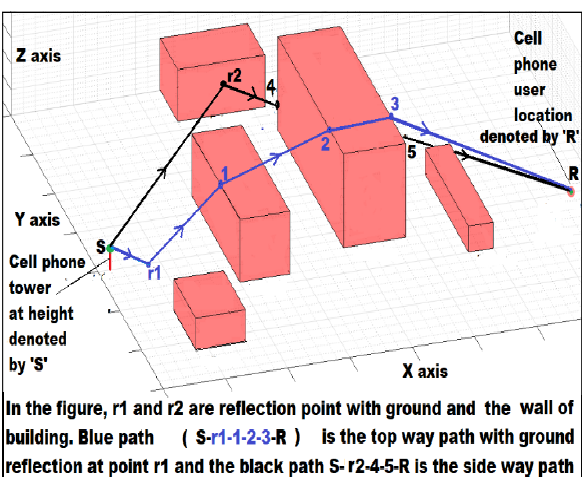
Figure 6. A signal path over the top of buildings(S. Bharadwaj